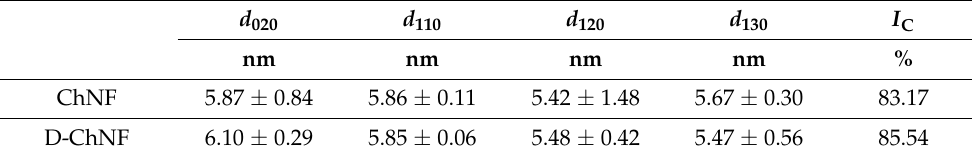
Table 1. Crystallographic analysis.